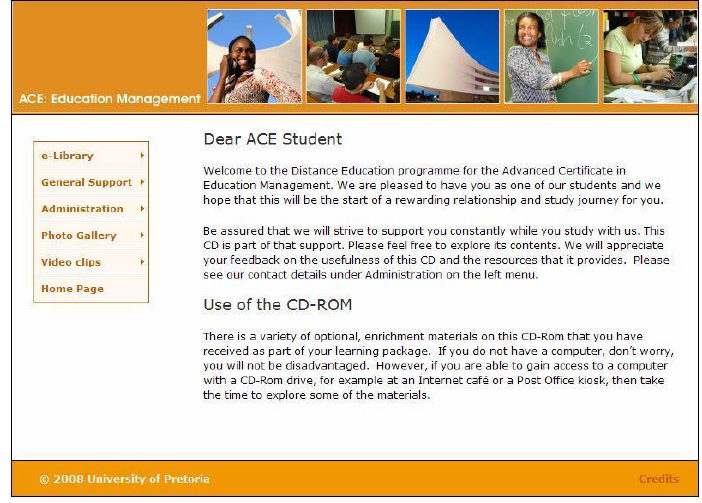
Figure 6 . Home page of the supporting